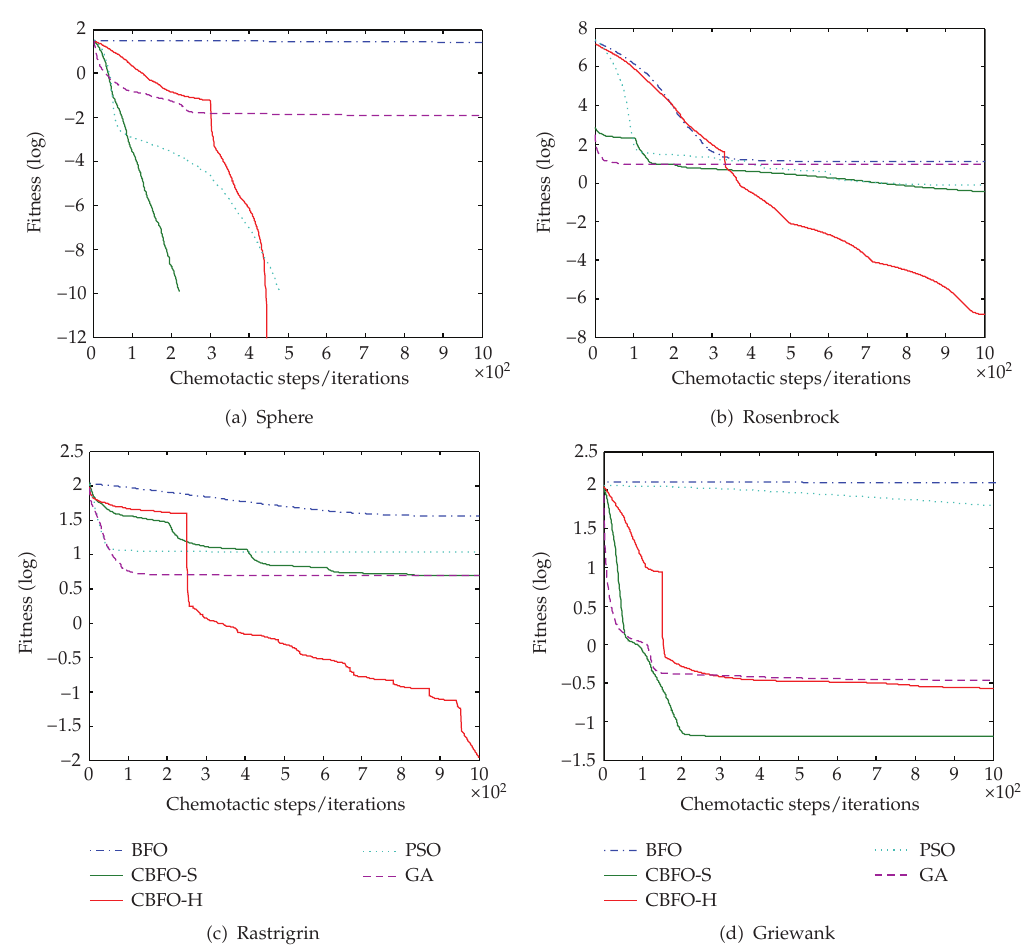
Figure 4: Convergence results of all